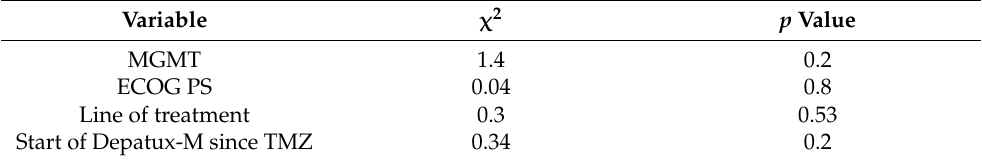
Table 5. Factors correlating with disease control.